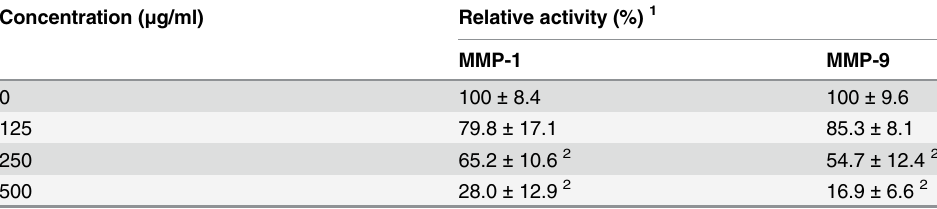
Table 1. Effect of Daiokanzoto on the activity of MMP-1 and